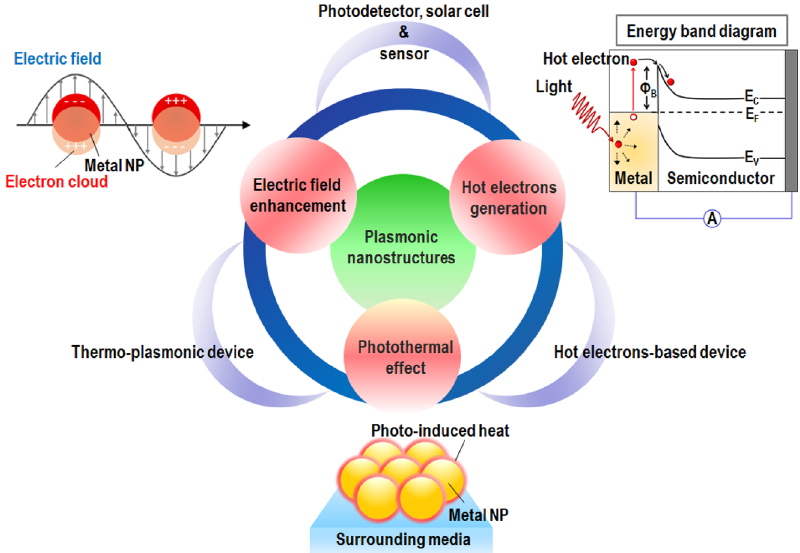
Figure 1: Schematic representation of the characteristics of